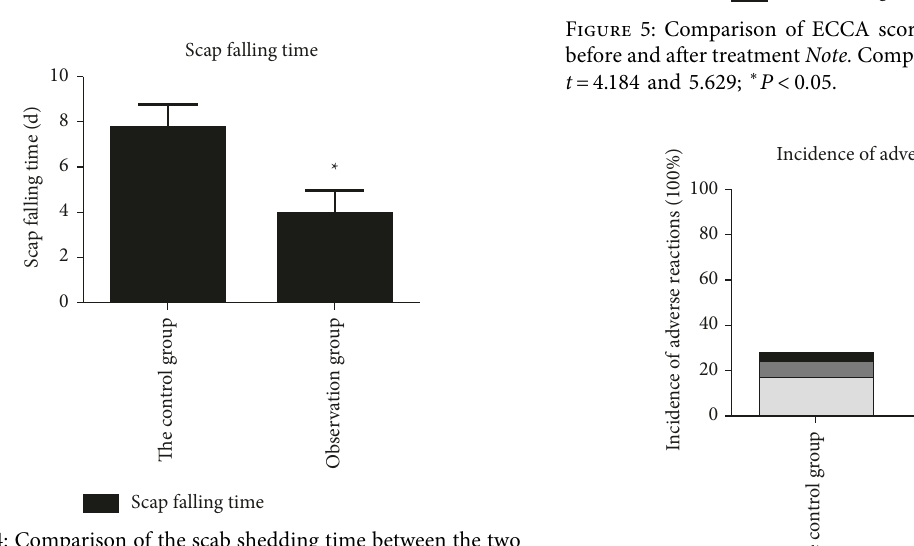
Figure 3: Comparison of the duration of pain between the two groups.